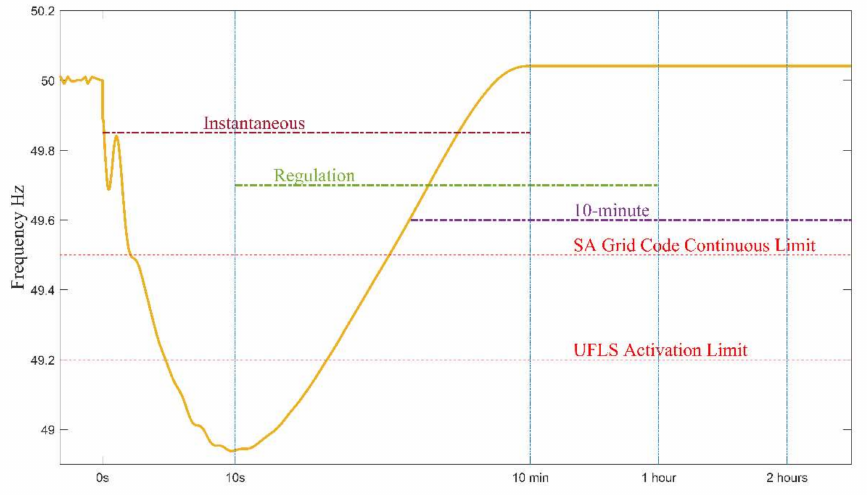
Figure 2. Activation and sustained times of reserve for Eskom to restore frequency during a significant system fault. Partially adopted from